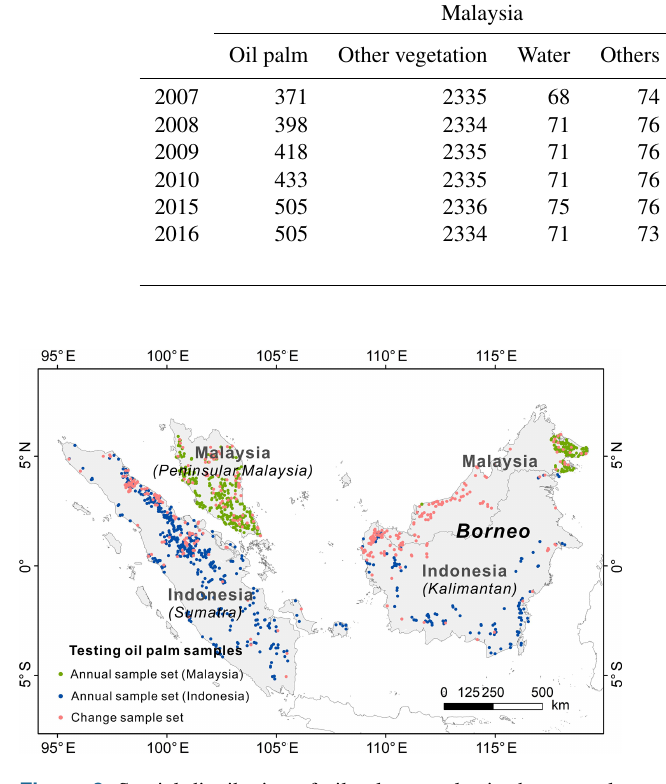
Figure 3. Spatial distribution of oil palm samples in the two val- idation datasets. The annual sample set contains 2986 (in 2016) samples in Malaysia, which were interpreted for 2007, 2008, 2009, 2010, 2015 and 2016, and 7667 (in 2016) samples in Indonesia, in- terpreted from 2010 to 2016. These samples were used to validate the annual maps developed from PALSAR and PALSAR-2 data. Of the annual sample set in Malaysia, oil palm samples consist of 16.92% (505), while the forest, water and others consist of 78.16%, 2.48% and 2.44%, respectively. The Indonesian annual sample set contains 601 (7.84%) oil palm samples, and the rest (92.16%) were other types. The change sample set includes 370 oil palm samples which were converted in the interpolated period (2001–2006 and 2011–2014). This sample set, with change year labelled, is used to assess the change detection result in the gap